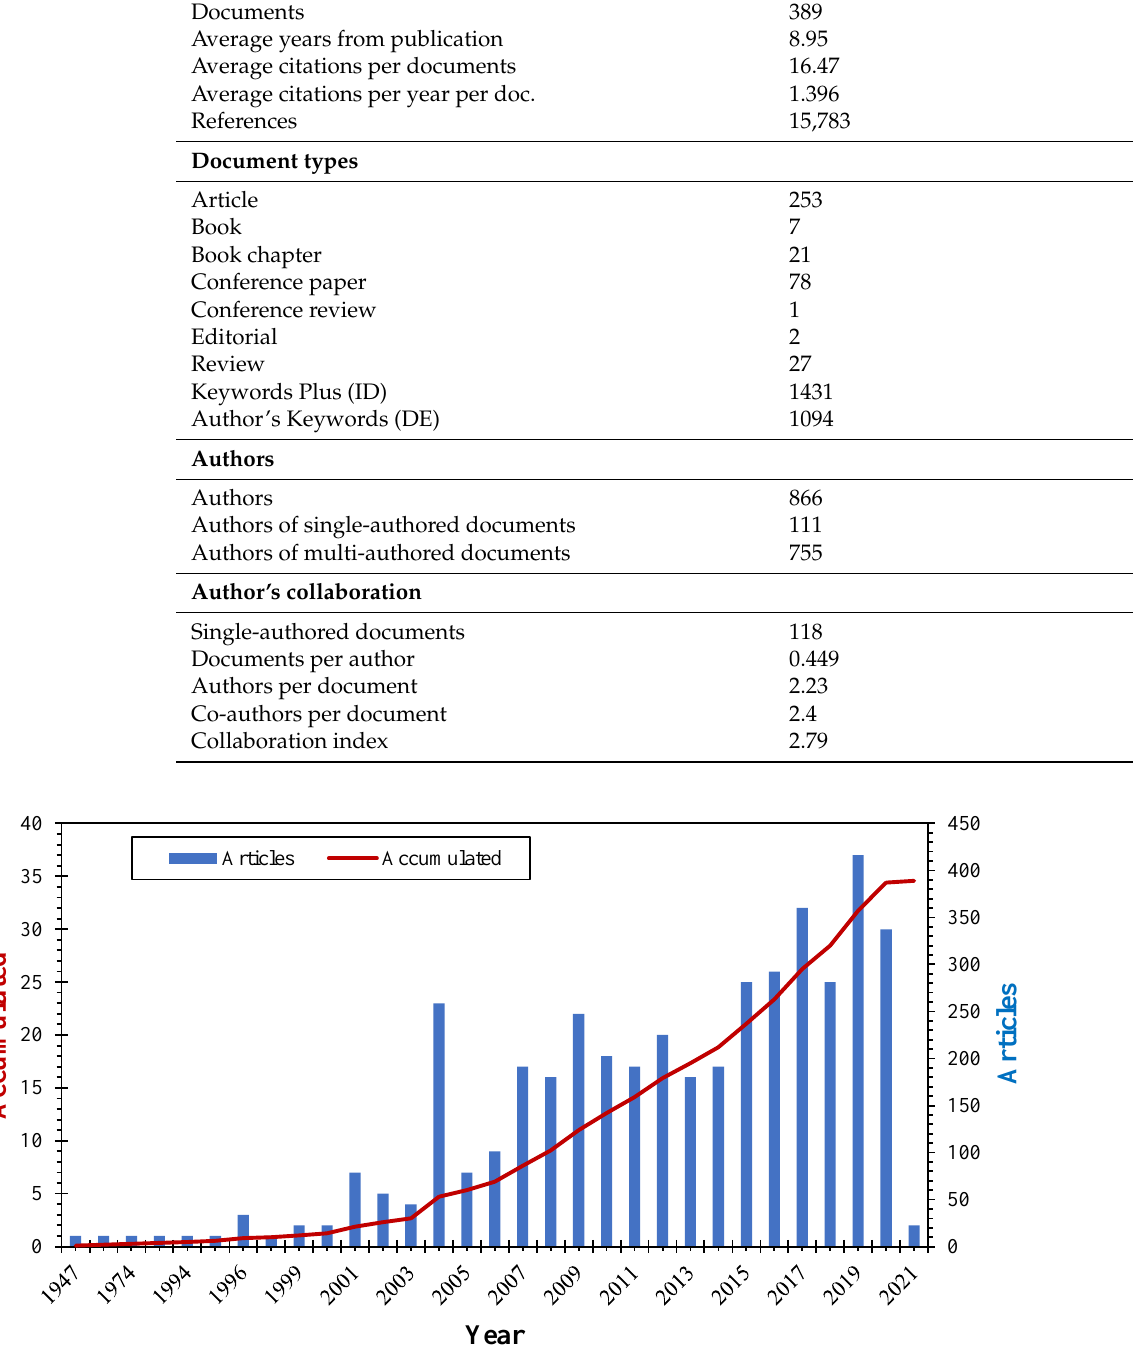
Figure 3. Accumulated articles across time for intellectual capital.